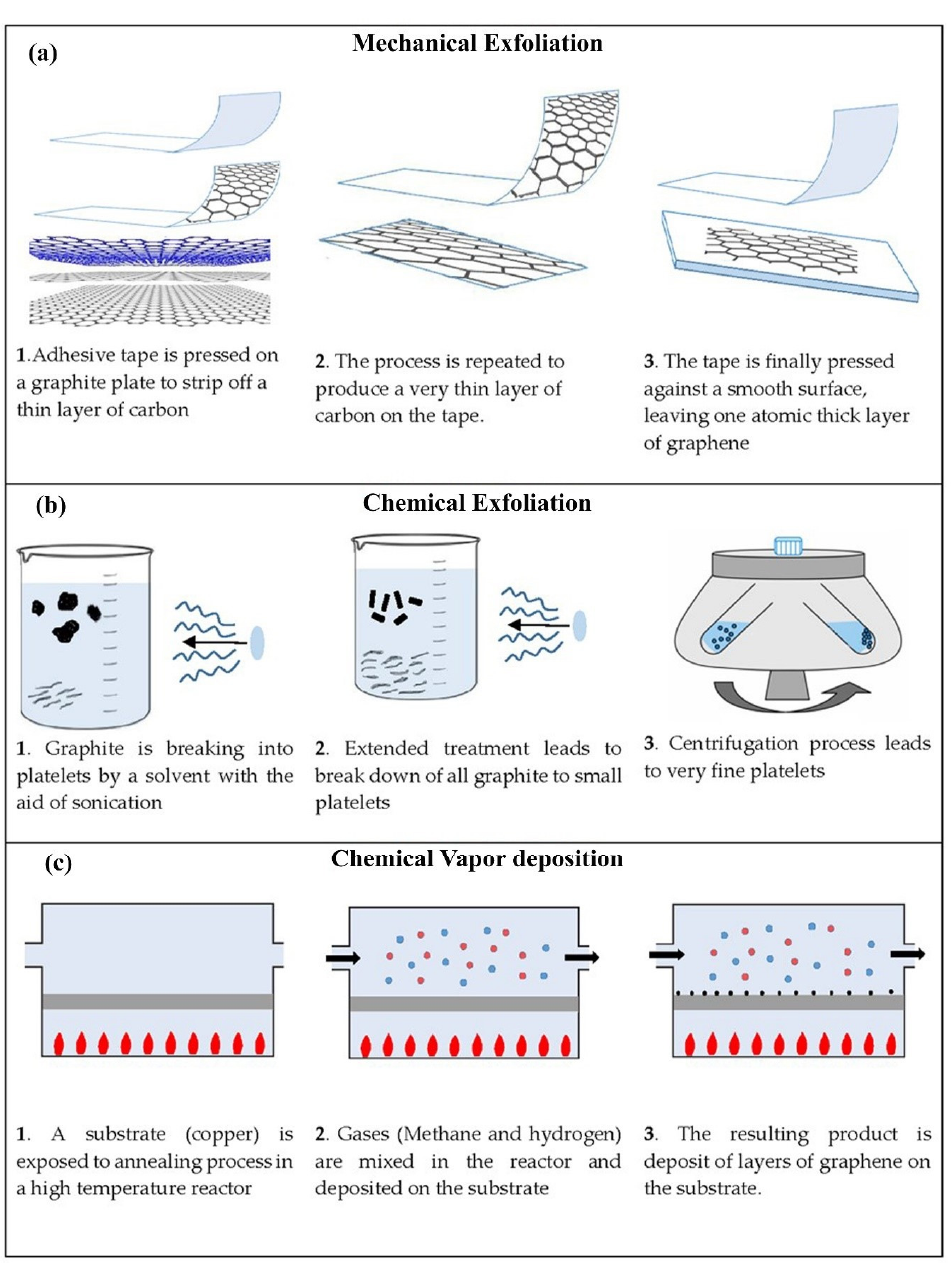
Figure 2. A schematic showing the main graphene production techniques. ( a ) Mechanical exfolia- tion. ( b ) Chemical exfoliation. ( c ) Chemical vapor